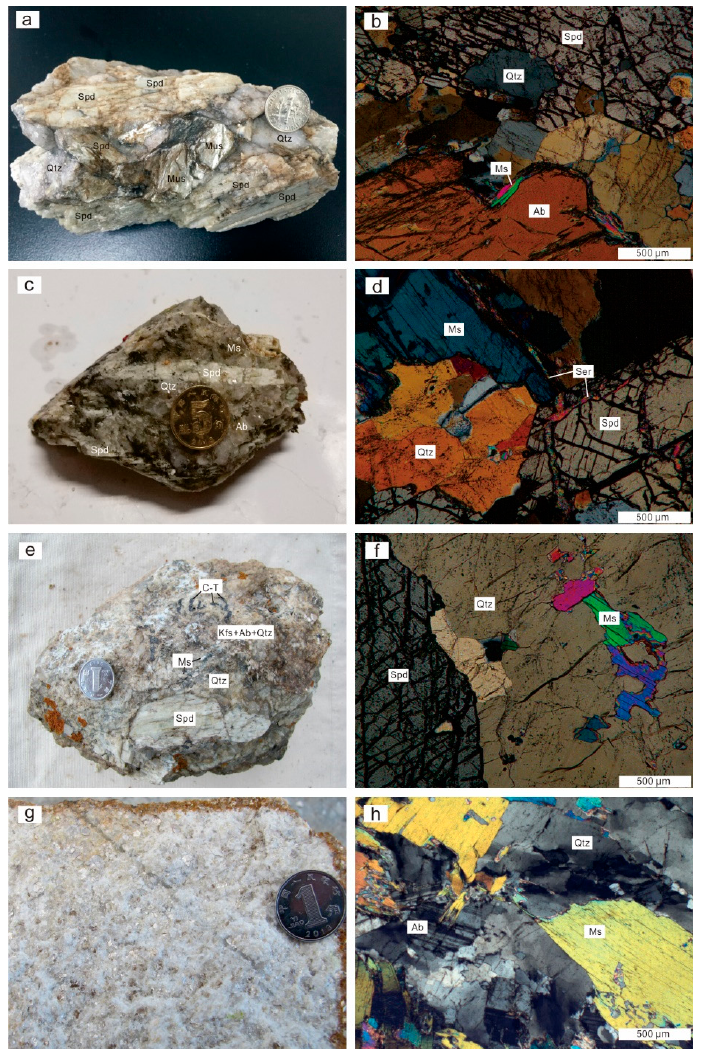
Figure 7. Hand specimen (left) and thin section (right) photographs illustrating sample structure, grain size, and major mineral assemblages of pegmatites and granite. Qtz: quartz; Ms: muscovite; Ab: albite; Kfs: K-feldspar; Spd: spodumene; C–T: columbite–tantalite. ( a , b ) Dahongliutan spodumene pegmatite; ( c , d ) Ke’eryin spodumene pegmatite; ( e , f ) Zhawulong spodumene pegmatite; ( g , h ) Zhawulong muscovite granite.